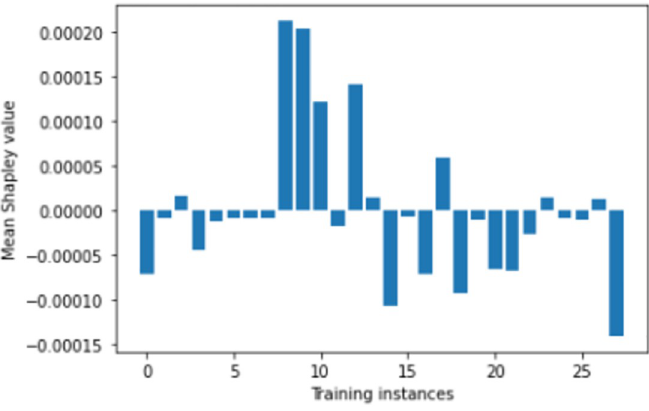
Fig 6. Estimation of input attribution for “FreezerSmallTrain” dataset.